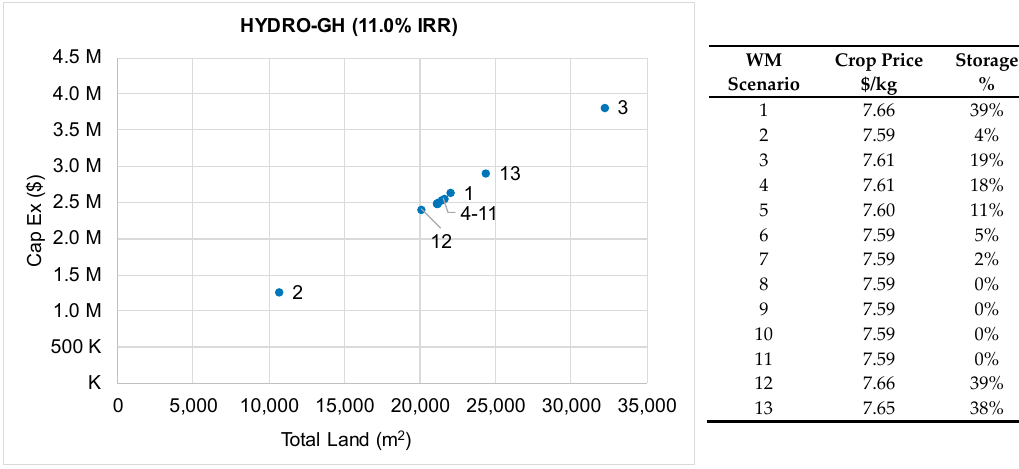
a fraction of the annual RAS wastewater load, drop from 36% (2.0 mL) in SOIL-FIELD and 39% (2.1 mL) in HYDRO-GH in Scenario 1, to 4% (0.22 mL) and 5% (0.27 mL), respectively in Scenario 2. The greater reduction in SOIL-FIELD capital expenditure was due to the relative cost of storage per unit area (AUD 80.00) compared to capital costs for the SOIL-FIELD horticulture system ($3.20), as well as disposal being relatively cheap (AUD 0.19/m 3 ). The breakdown of capital expenditure for SOIL- FIELD and HYDRO-GH, shown in Figure 8 and Figure 9 respectively, explains the relative costs for components of the two end-of-pipe HRS across the 13 water management scenarios.